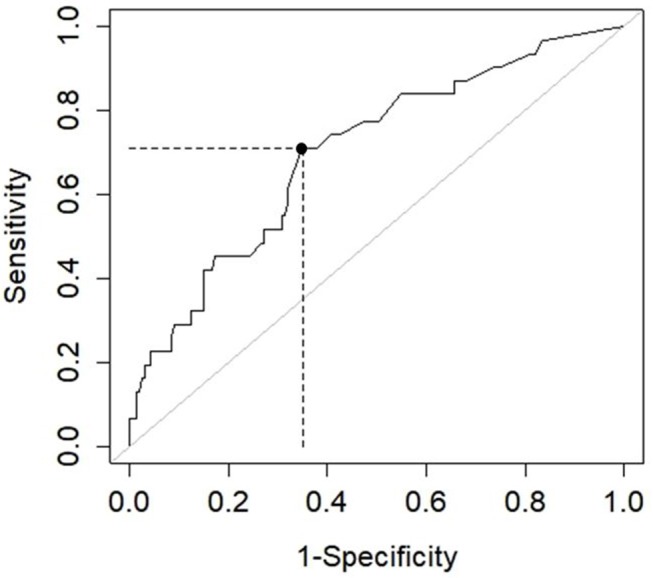
ROC curve for the fitness-to-drive screening measure short-form. AUC = 0.72, p < 0.05, CI 95% [0.62–0.82], sensitivity = 0.71, specificity = 0.65, positive predictive value = 0.27, and negative predictive value = 0.92.